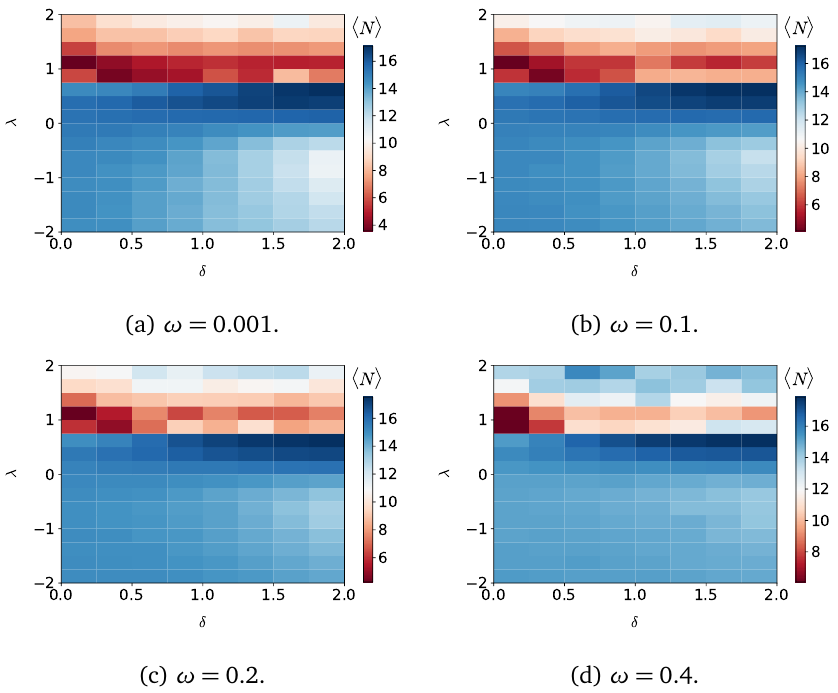
Figure 17: Heat maps of 〈 N 〉 as a function of λ and δ , for different values of ω , with α = 1, β = 0, γ = 1, and Q =